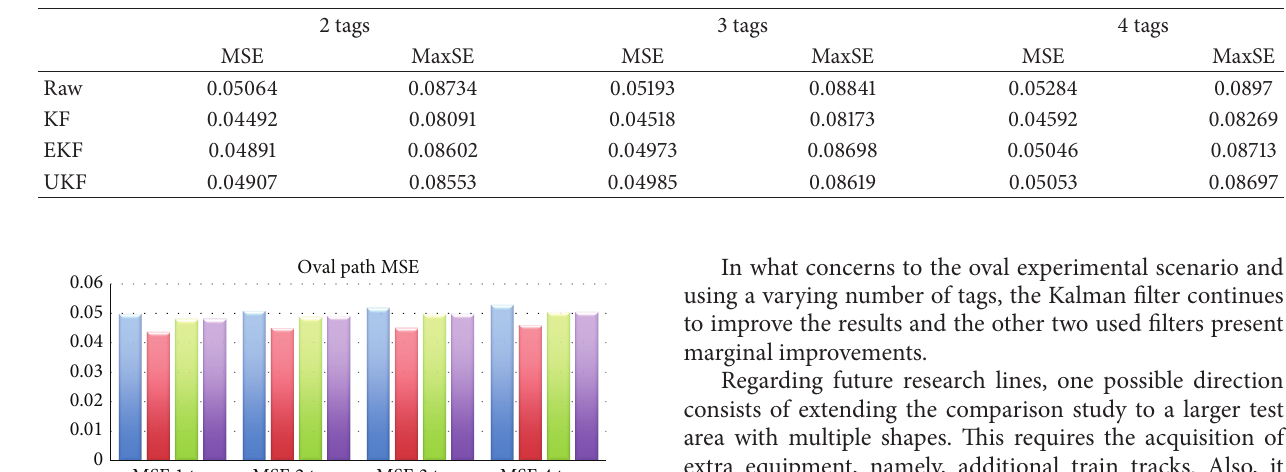
Table 5: Oval path results with multiple tags.